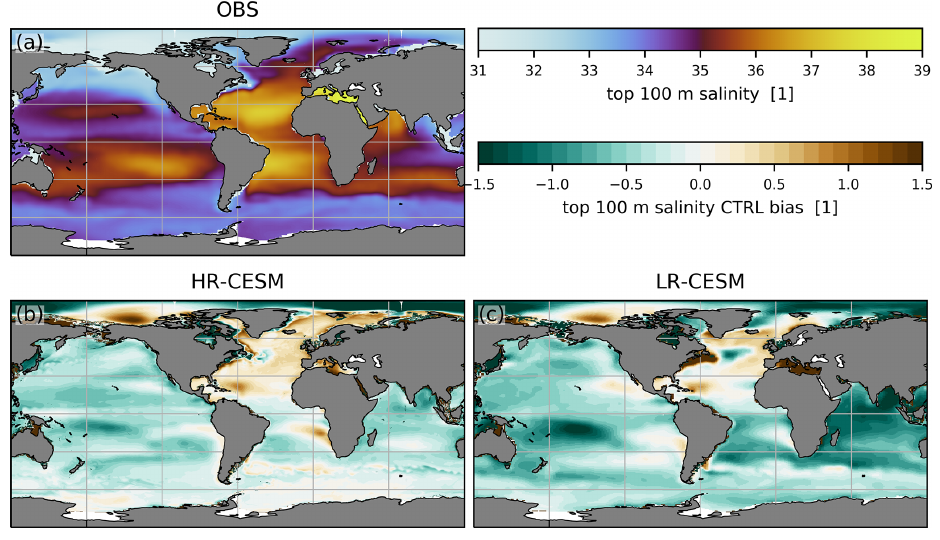
Figure A3. The salinity bias of the upper 100m, like Fig. 3.